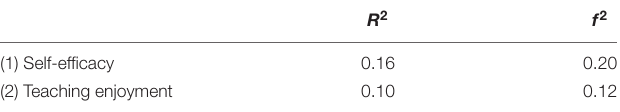
TABLE 3 | Standardized parameter estimates for the structural model. R 2 f